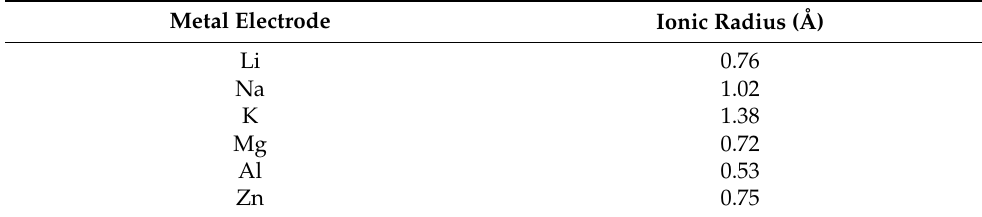
Table 1. Ionic radius of metal electrodes